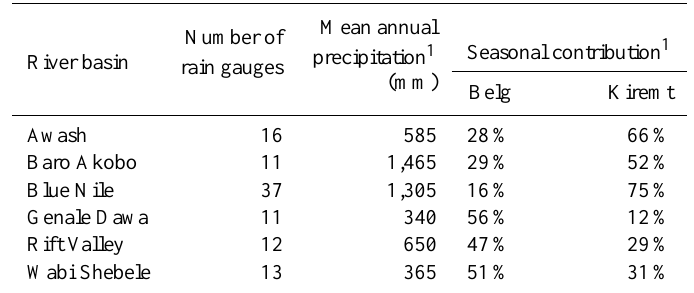
Table 3. River basin precipitation